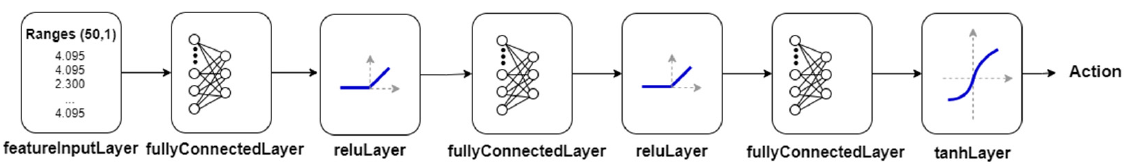
Figure 7. Actor network with 50-D input and 2-D output.